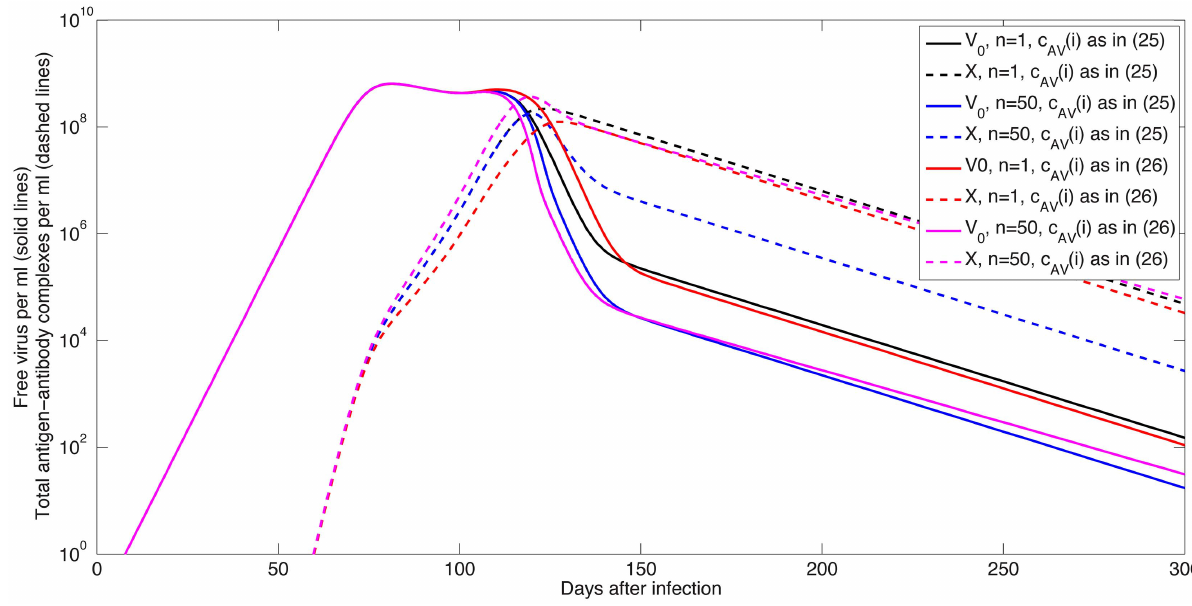
X n Figure 6. Free virus V 0 (solid lines) and total complexes V i (dashed lines) as given by model (27) for n ~ 1 , n ~ 50 , c AV ( i ) given i ~ 1 by (25) (black and magenta lines) and c AV ( i ) given by (26) with c 1 ~ 3 c , h ~ 1 and i 50 ~ n = 2 (red and blue lines). The binding and unbinding rates are normalized so that nk p = k m is constant. The other parameters are as in Tables 1 and 2 (median values).